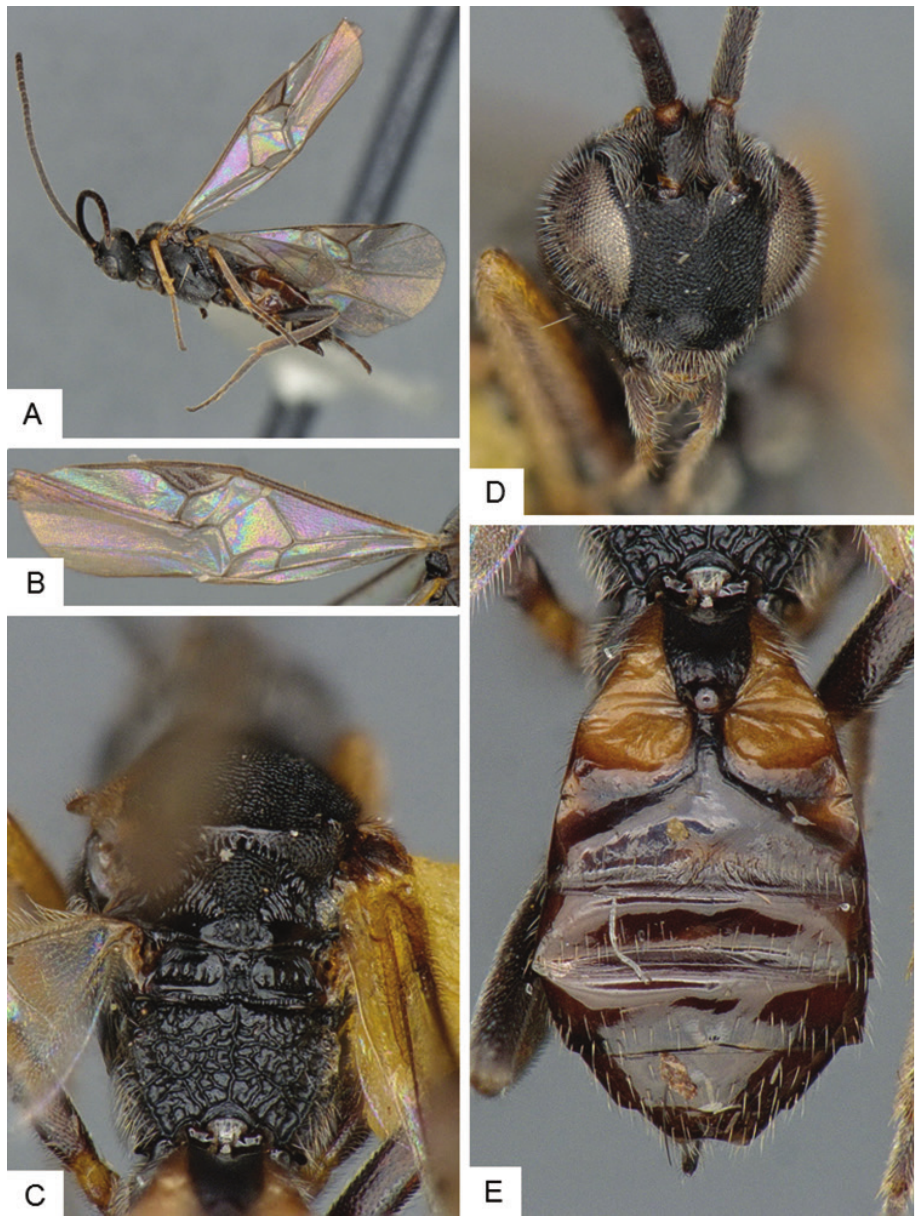
Figure 30. Microplitis sp. near sofron . A Habitus, lateral B Fore wing C Mesosoma, dorsal D Head, frontal E Metasoma,